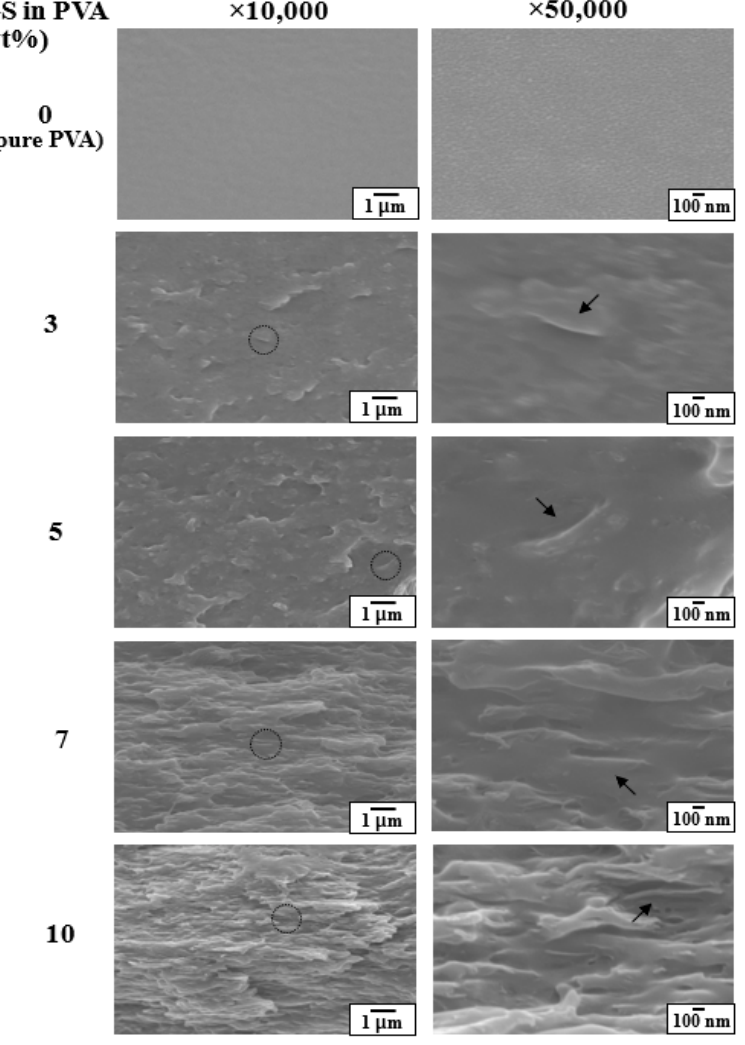
Figure 6. SEM micrographs of PVA hybrid films with various HDA-GS contents.